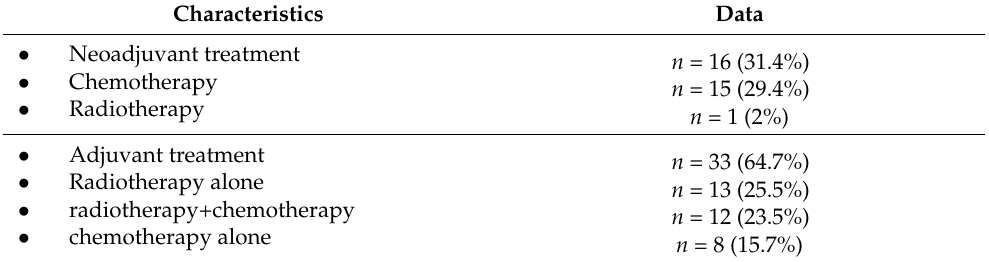
Table 1. Cont. Characteristics Data